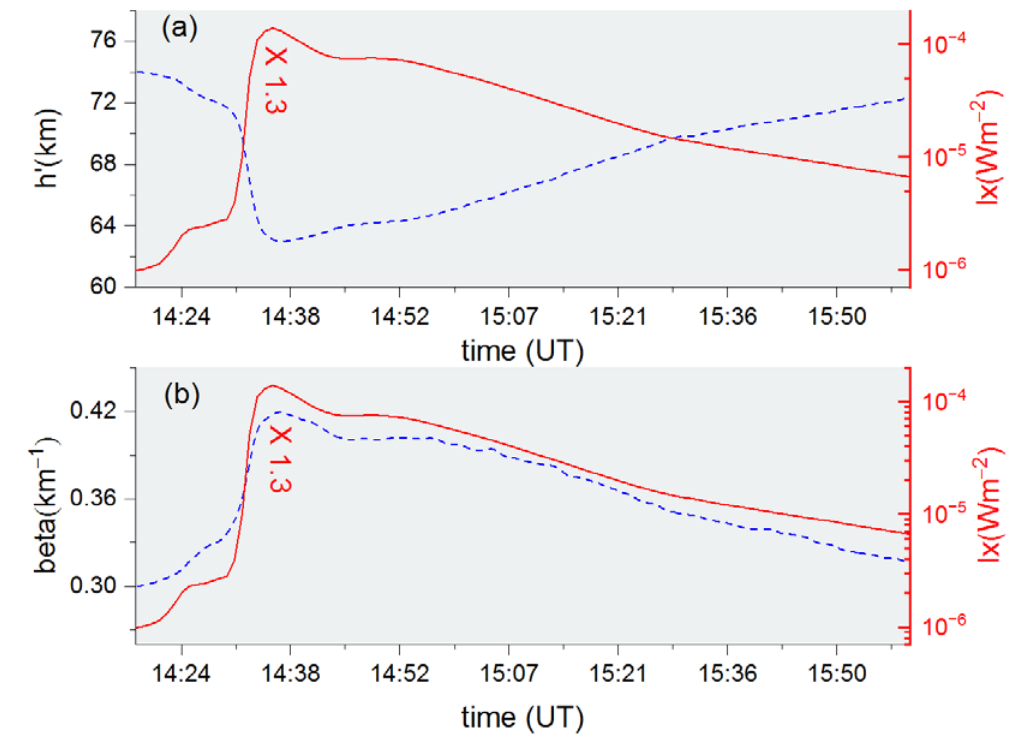
Figure 2. Parameters H ’ ( a ), and β ( b ) and X - ray flux (right axis) during occurrence of X1.3 class SF on 7 September 2017.